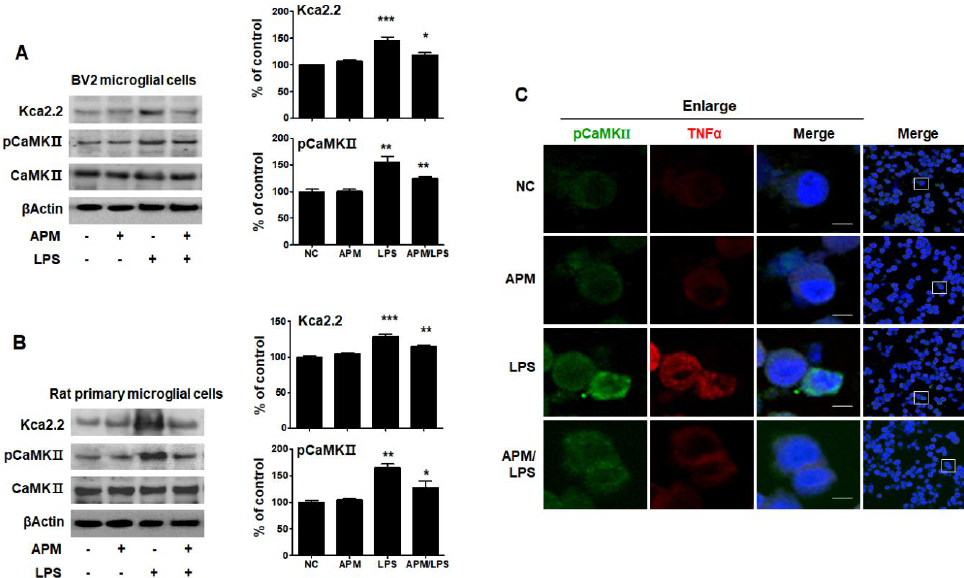
Figure 2. APM inhibits LPS-induced SK channels in BV2 and rat primary microglial cells. Cells were treated with APM for 1 h followed by LPS for 6 h. APM significantly inhibit LPS-induced K Ca 2.2 and pCaMKII expression in BV2 ( A ) and rat primary microglial cells ( B ). Immunofluorescence double staining for pCaMKII (green) and TNF α (red) localization ( C ) in BV2 microglial cells. Cell were counterstained with DAPI (blue). Magnification 400×. Enlarge figure of scale bars: 5 μm. βActin was used to confirm equal sample loading. K Ca 2.2 and pCaMKII followed by densitometric analysis. The data are representative of three independent experiments and quantified as mean values ±